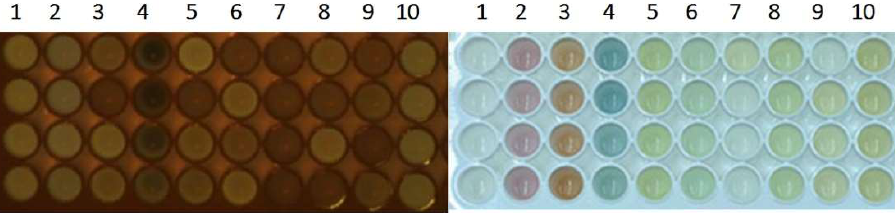
Figure 4. Near-IR fluorescence (left) and visible (right) images of a portion of a 96-well plate with the reacting system dye 2 − H 2 O 2 − Cu(2+) at 2 min (NIR) and 5 min (vis) after the reaction start. Without analyte (1st column) and with analytes: 2—promethazine, 3—promazine, 4—chlorpromazine, 5—ceftriaxone, 6—cefazolin, 7—ceftazidime, 8—cefotaxime, 9—benzylpenicillin, 10—ampicillin. All experiments in the column are parallel runs. Conditions: 30 µ L each of the following: 0.067 M phosphate buffer (pH 7.4), 1 mM CTAB, 5 mM model analyte, 0.1 g/L dye 3, 1 M H 2 O 2 , and 0.1 mM CuSO 4 ; 120 µ L of